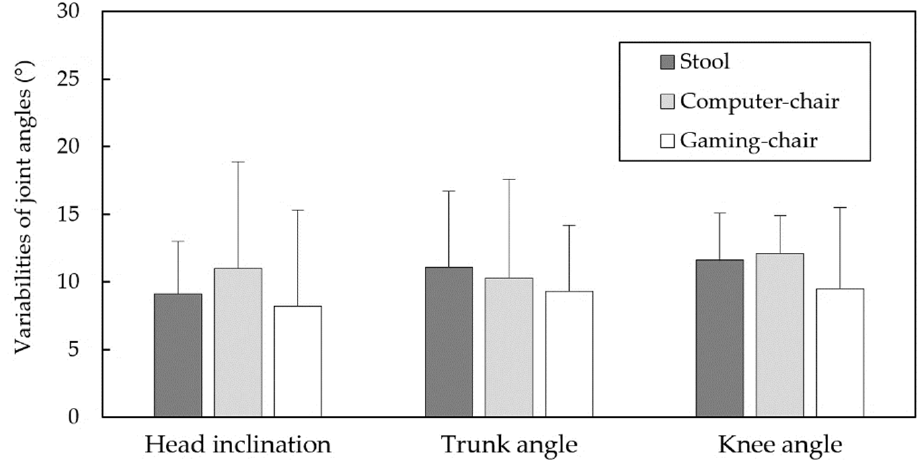
Figure 3. Comparisons of variabilities of joint angles for various test combinations.